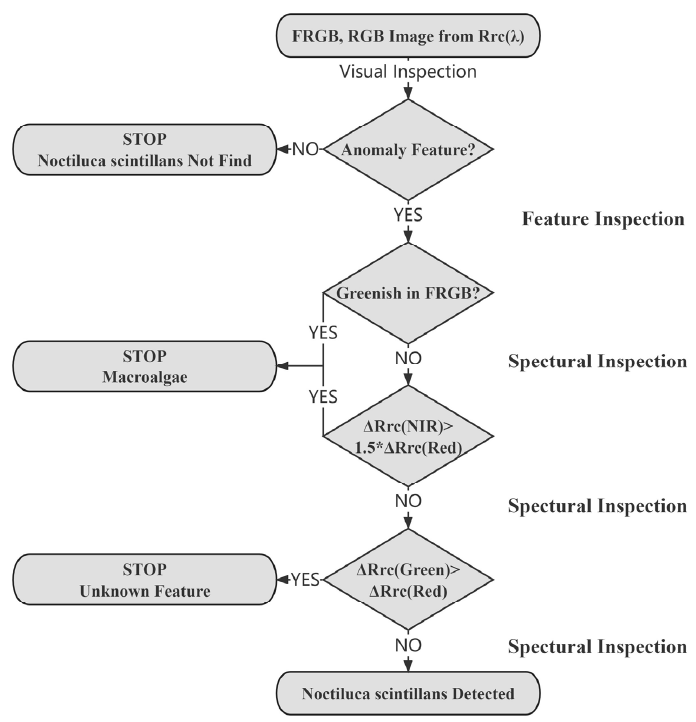
Figure 5. Flowchart of labeling the NSB region.